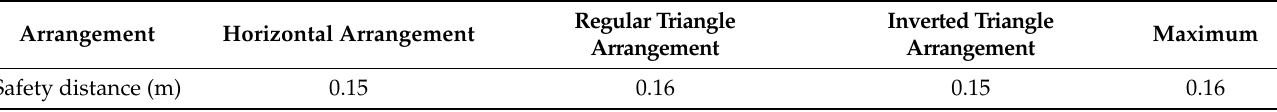
( b ) ( c ) Figure 3. Electric field distribution around transmission lines with different arrangements of 10 KV voltage levels. ( a ) Field strength distribution under 10 kV inverted triangle arrangement; ( b ) field strength distribution under 10 kV horizontal arrangement; ( c ) field strength distribution of 10 kV